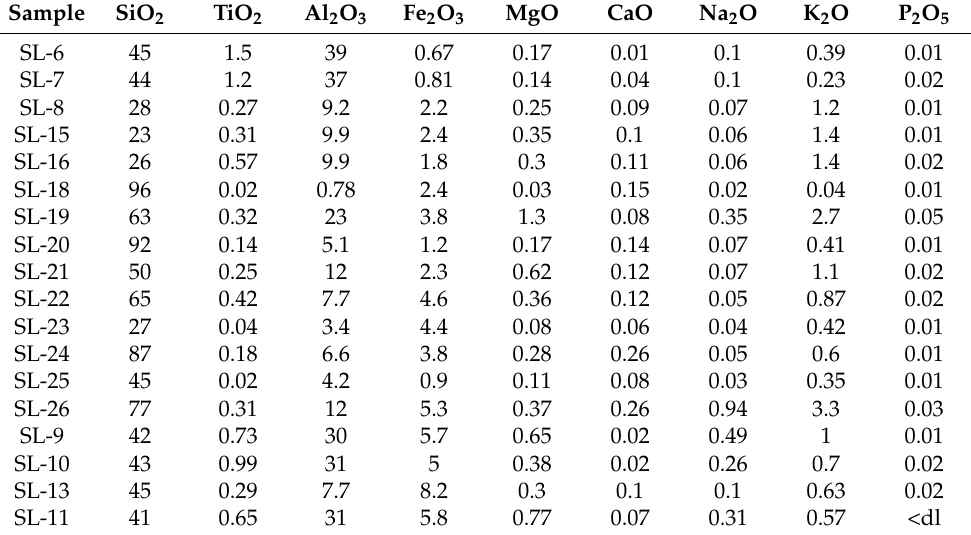
Table 3. Major-element oxides (%) of the coal and non-coal samples from the outcrop profile in the Xian’an Coalfield (on whole-coal